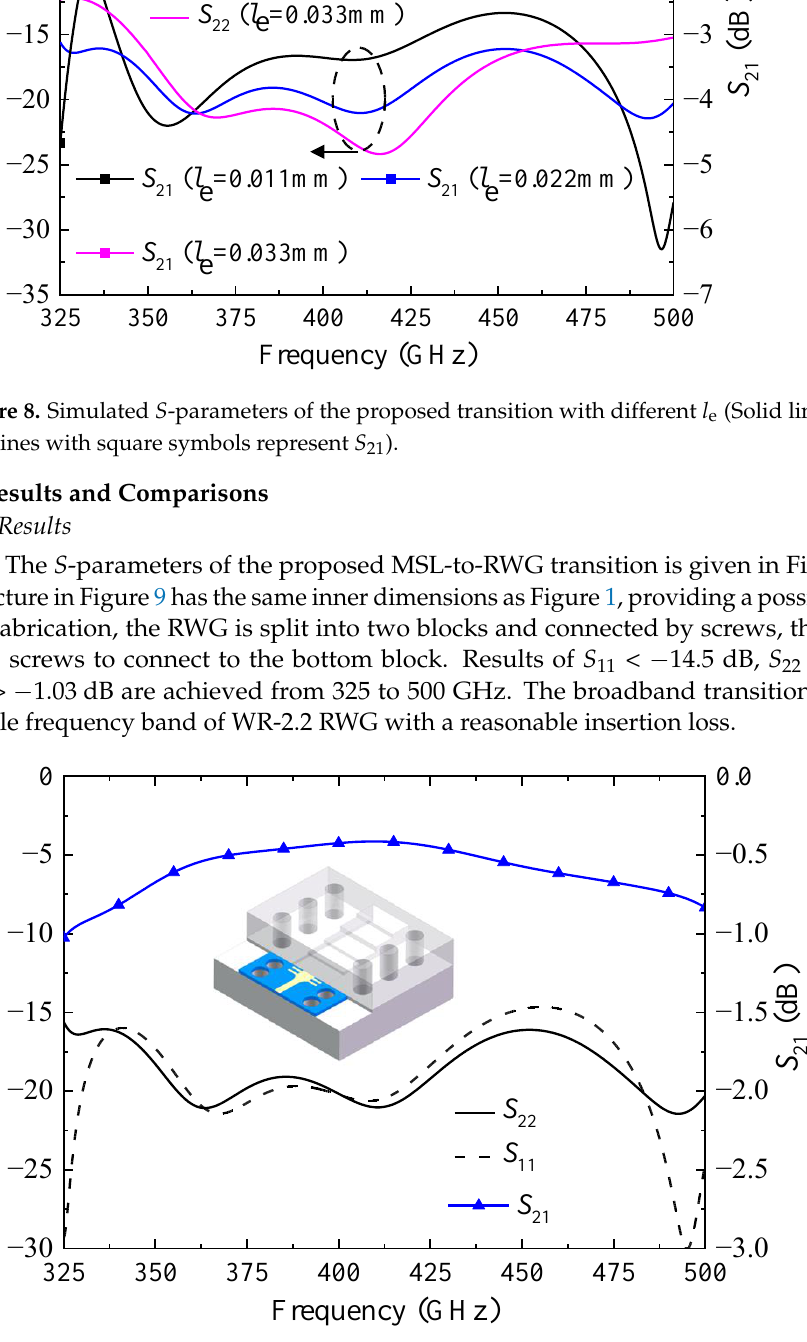
Figure 9. S -parameters of the proposed MSL-to-RWG transition. Table 2. Comparisons between different H -plane MSL-to-RWG transitions. Ref.